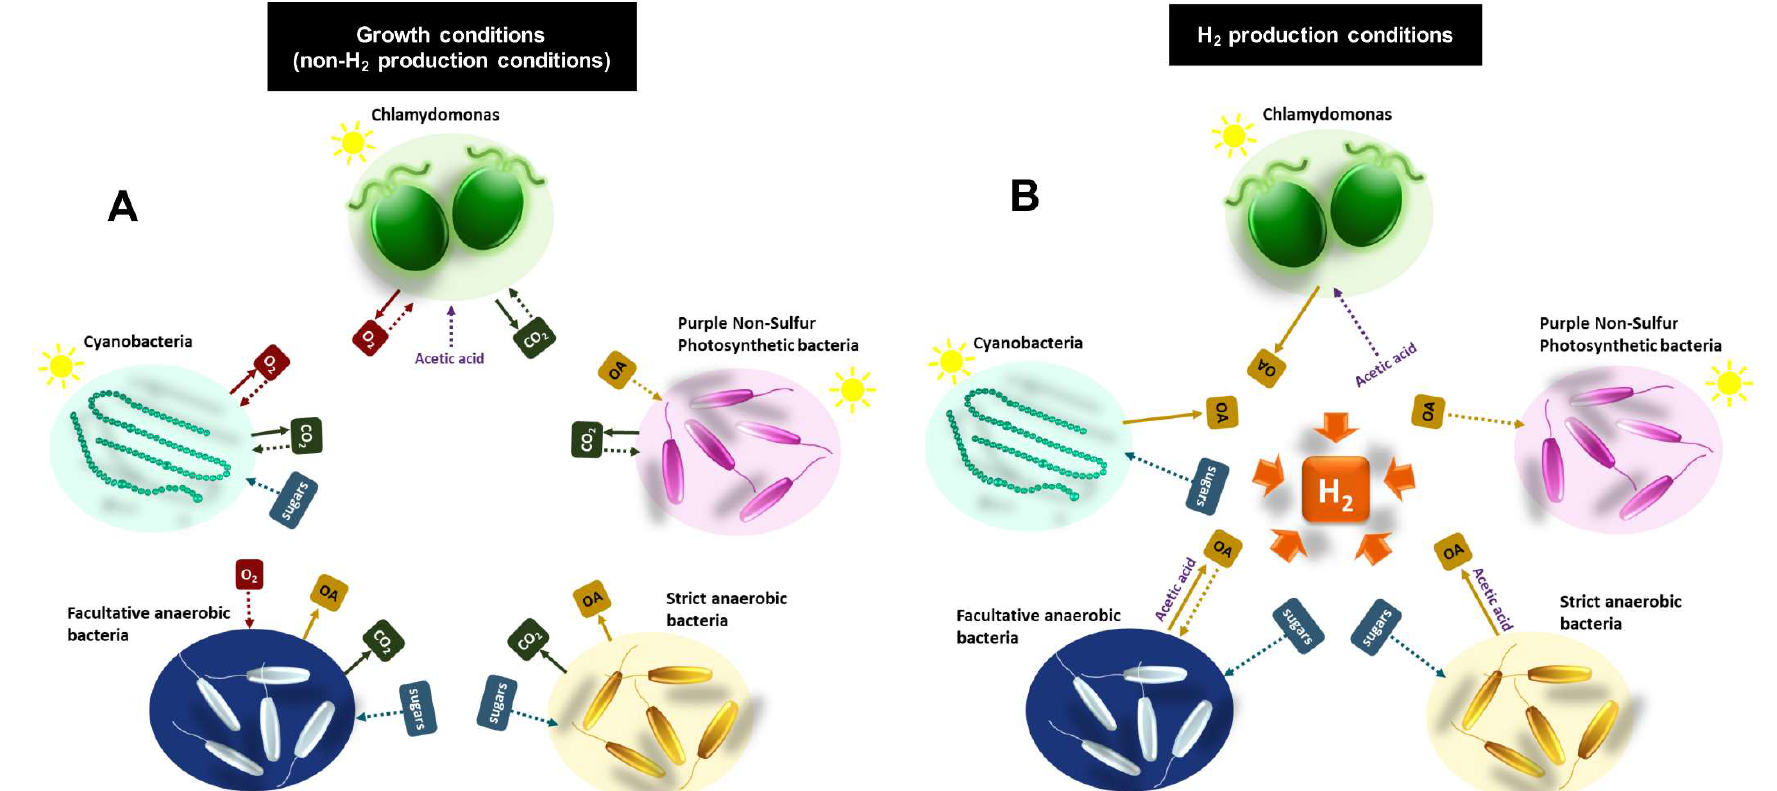
Figure 2. Potential metabolites exchanged among different H 2 -producing microorganisms during growth conditions ( A ) and H 2 -producing conditions ( B ). The secretion and uptake of metabolites are indicated with plain and dotted arrows, respectively. Depending on the specific culture conditions the same metabolites can be secreted or accumulated. Organic Acids (OAs) mainly include ethanol, glycerol, formate, acetic acid, lactate, succinate and butyrate. When predominant, the specific OA is indicated next to the arrow.